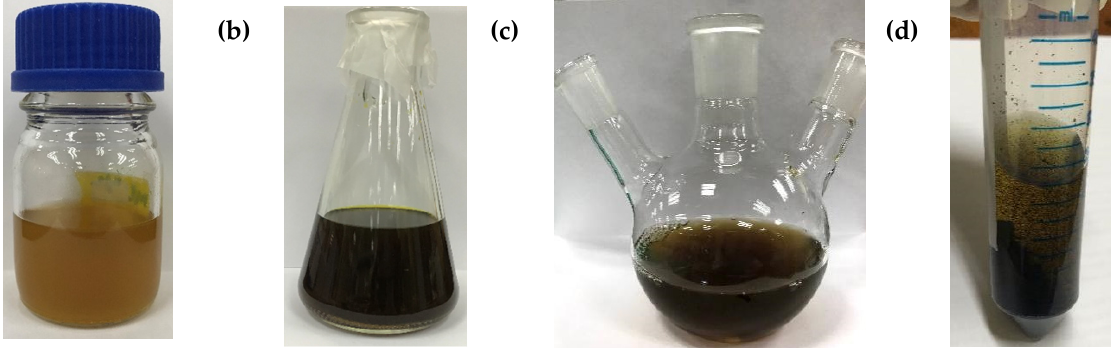
Figure 2. Photographs of the ( a ) GO dispersion, ( b ) the C. nutans leaf extract, ( c ) a mixture of GO and the C. nutans leaf extract, and ( d ) reduction suspension.